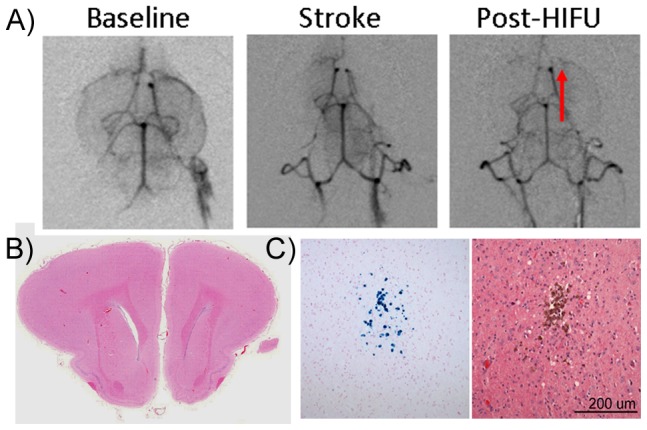
HIFU (415 W) causes partial recanlization in 50% of blocked vessels.A) Recanalization was observed in angiograms taken post-HIFU treatment. 2/4 (50%) of animals treated with 415 W power, exhibited recanalization when compared to post-stroke angiograms. There was no damage or leakage from the vessel apparent on the angiogram. B) Post-treatment H&E showed no evidence of tissue damage or hemorrhage due to HIFU in the region of sonication or in the surrounding brain tissue. Scale bar = 500 µm. C) Prussian blue staining was used to detect small fragments of the disrupted iron-loaded blood clots. In one animal, small fragments were identified in the cortex, downstream of the MCA. Scale bar = 200 µm.